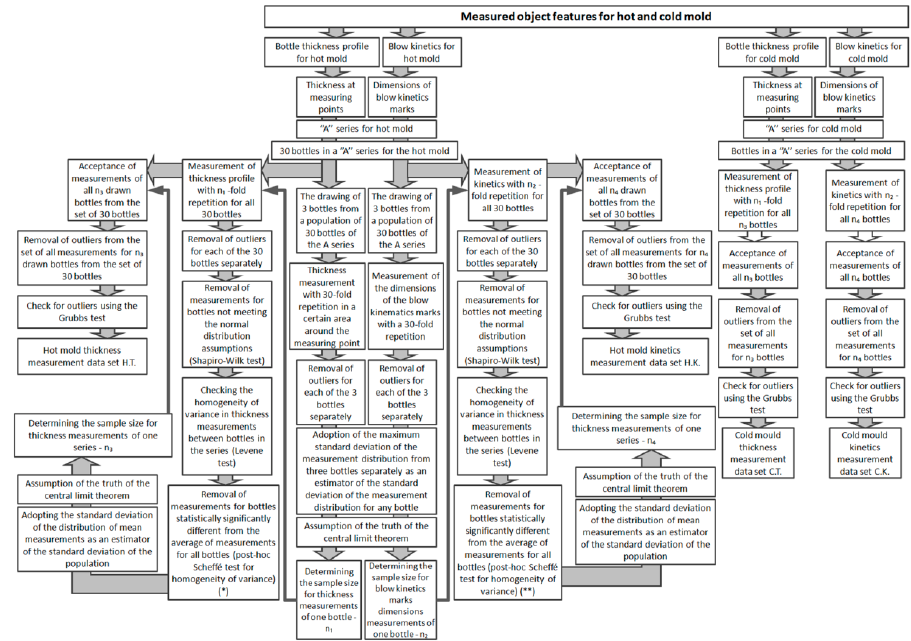
Figure A1. A method of statistical preparation of a set of measurement data for bottles for cold and hot filling, respectively for thickness (C.T., H.T.) and dimensions of blow kinetics determinations (C.K., H.K.) (sample size was determined in accordance with formula (1)); (*) data used to determine the process stabilization in terms of thickness profile, (**) data used to determine the process stabilization in terms of blow kinetics determinations. The specific area around the measuring point (with radius 2 mm) in which the thickness measurement with a 50-fold repetition was done as shown in Figure 5 for the I-3 point as an example.